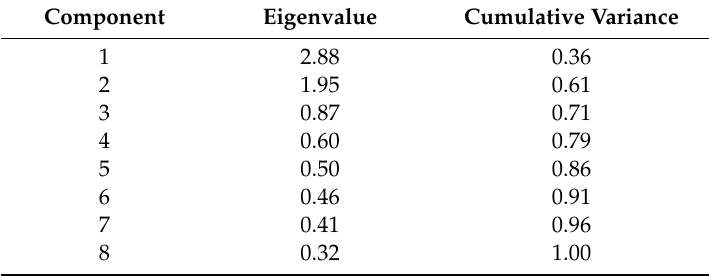
Table 8. Criteria for the factor analysis of the “religious” adolescents and young adults (N = 649)